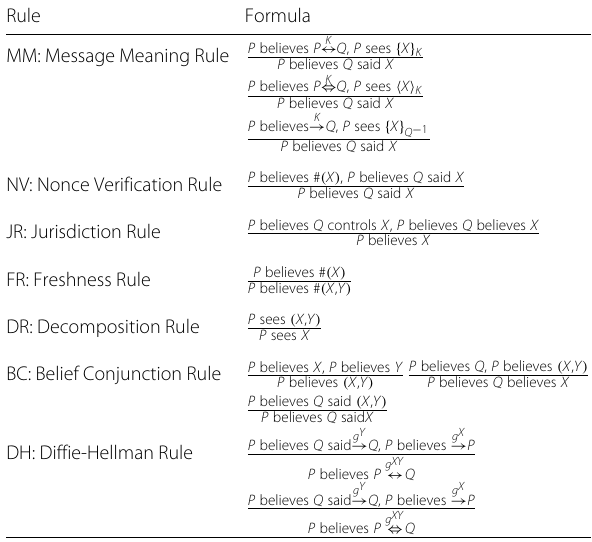
Table 3 Rules of BAN logic Rule